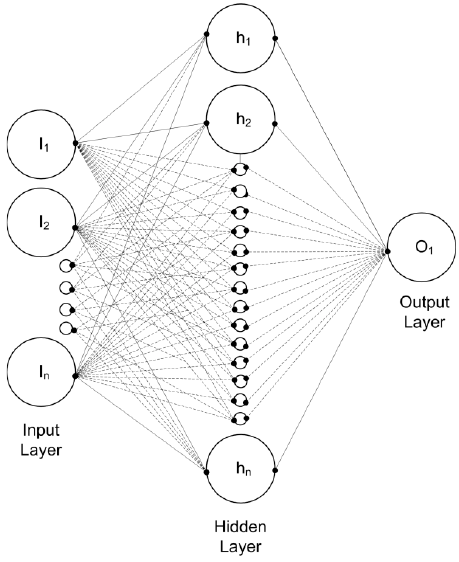
Figure 14. A neural network architecture with input layer, hidden layer, and output layer.